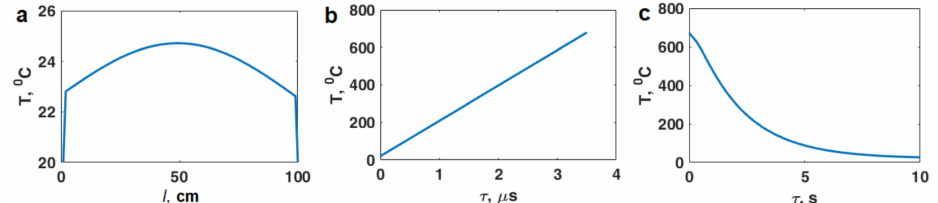
Figure 4. Thermal effect for microwave radiation of 2.85 GHz (S-band): ( a ) temperature distribution along the quarter-wave layer of the powder; ( b ) temperature dependence on the pulse duration; ( c ) temperature cooling dependence on time under the absence of irradiation.